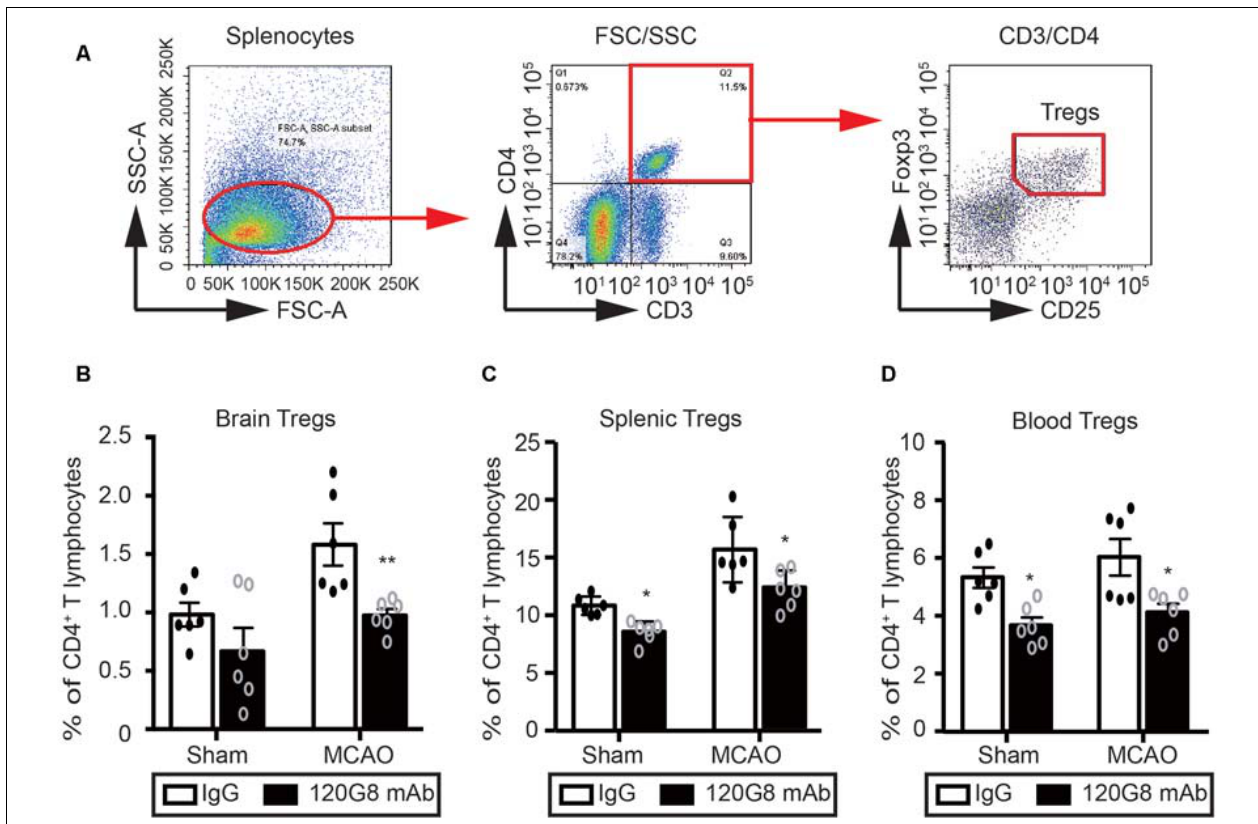
FIGURE 4 | Depletion of pDCs decreases the Tregs population in the periphery and brain followed by MCAO. One-hundred micrograms 120G8 mAb or rat IgG i.p.injection was conducted immediately before MCAO or sham procedure in mice. The brains, spleens and blood samples were collected 2 days after MCAO or sham procedures. (A) The gating strategy to identify the splenic Tregs. The Tregs population (CD3 + CD4 + CD25 + Foxp3 + ) in the (B) brain, (C) spleen and ( D) blood was analyzed with Flow cytometry. Data are expressed as means ± SEM for n = 6 mice per group. * p ≤ 0.05, ** p ≤ 0.01 vs. IgG group. The scatter plots represent independent